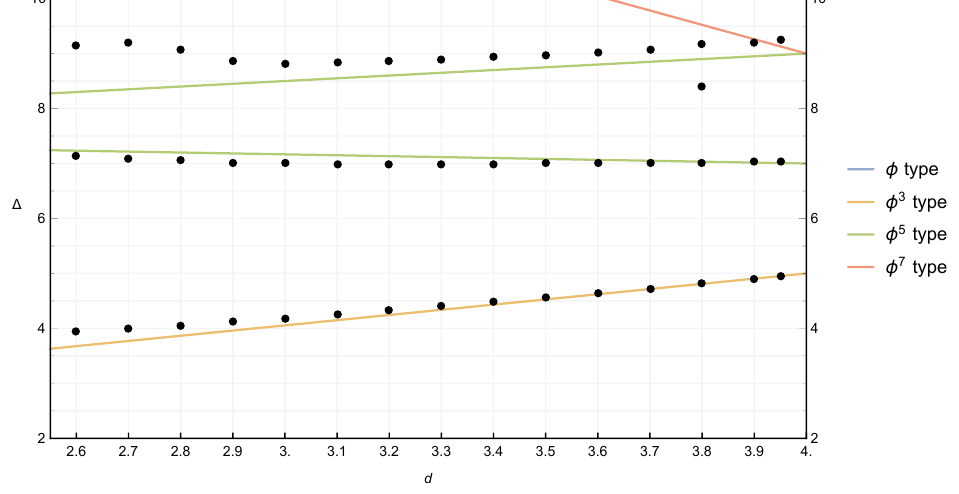
Figure 13 . Z 2 -odd operators of spin 2.